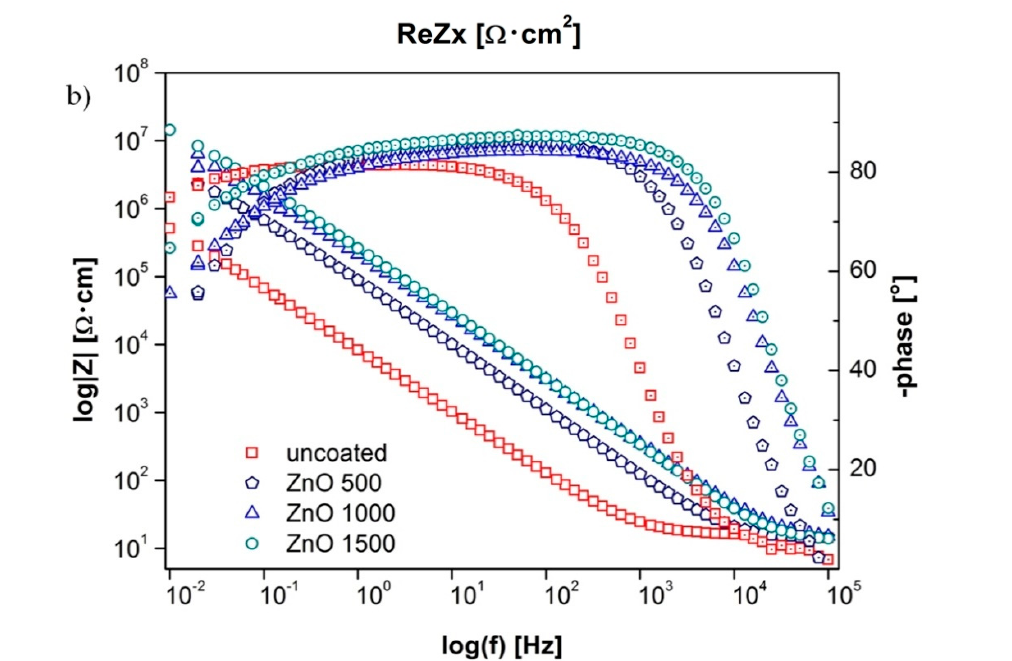
Figure 9. Impedance spectrum of the tested materials (for designated stationary potentials): ( a ) Nyquist representation and ( b ) Bode representation.